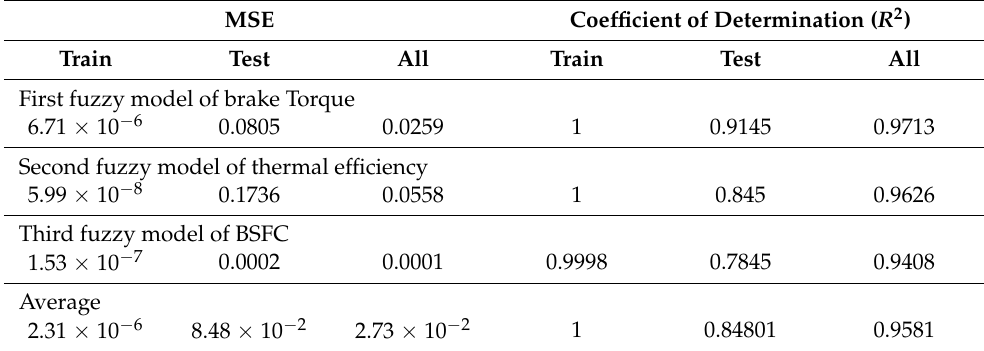
Table 6. Statistical evaluation for the fuzzy-based models. MSE Coefficient of Determination ( R 2 ) Train Test All Train Test All First fuzzy model of brake